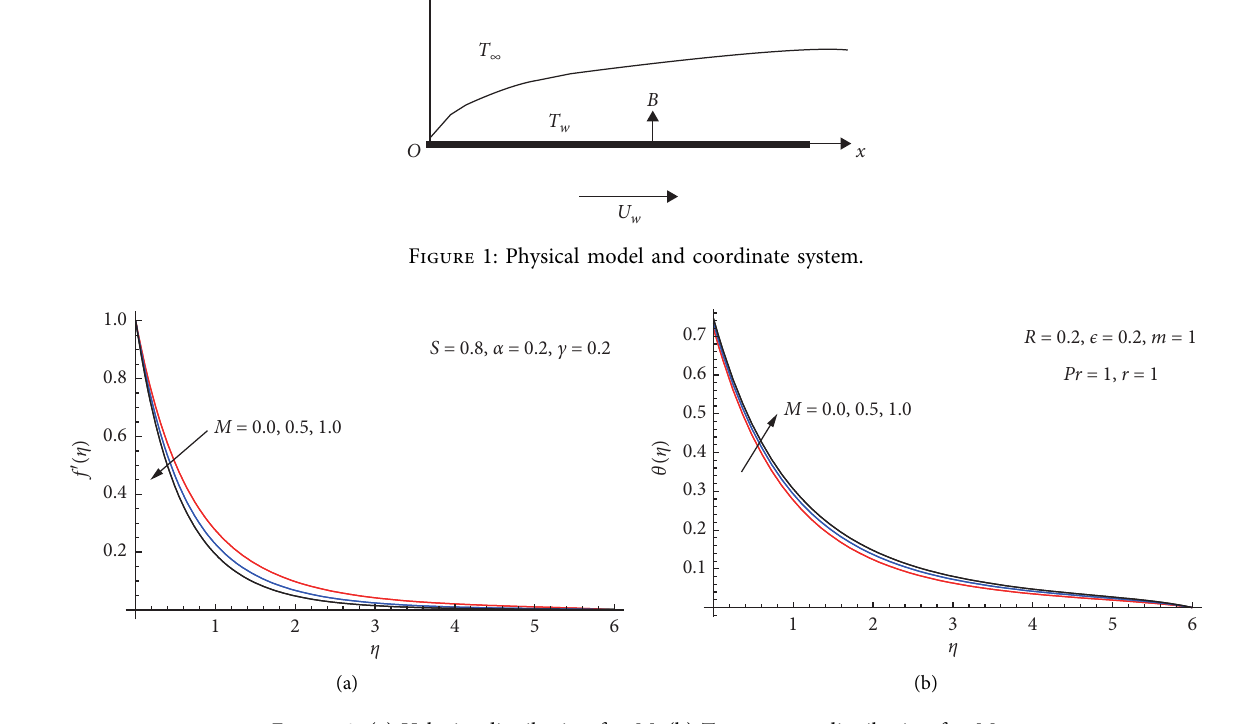
Figure 2: (a) Velocity distribution for M . (b) Temperature distribution for M .